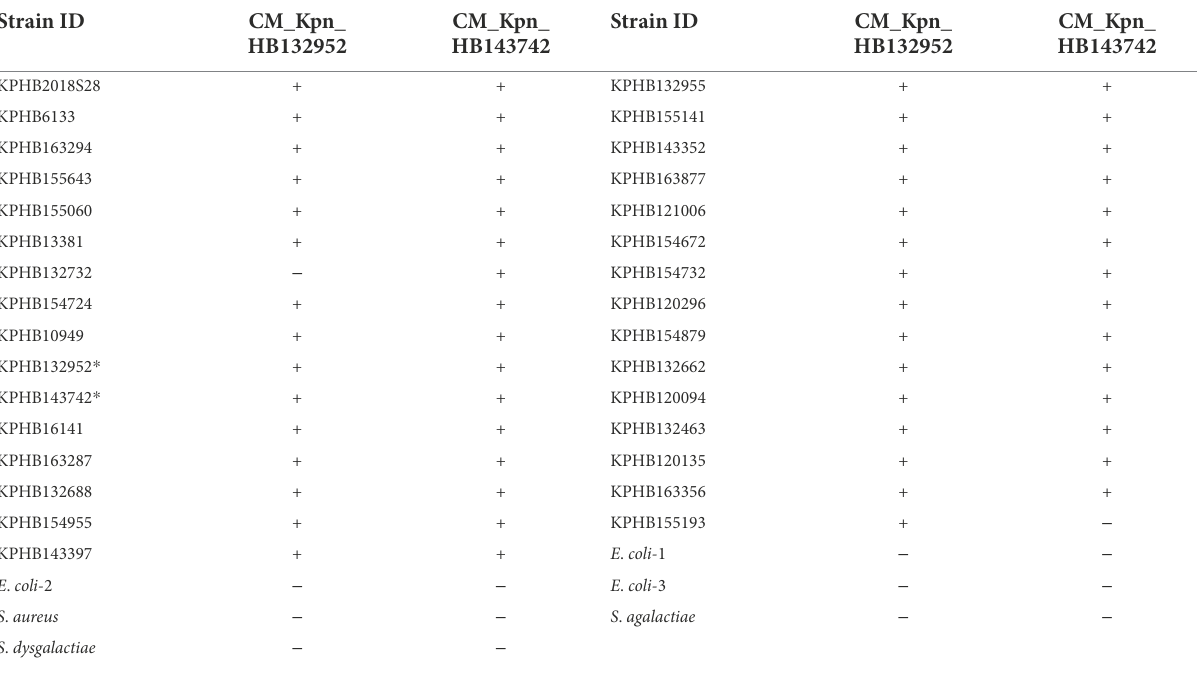
− (+) clear zones or ( − ) no plaques after infection of tested bacteria with both phages. KPHB132952 and KPHB143742 strains were used to induce phage CM_Kpn_HB132952 and CM_ Kpn_HB143742, and marked with an asterisk ( * ) in the upper right